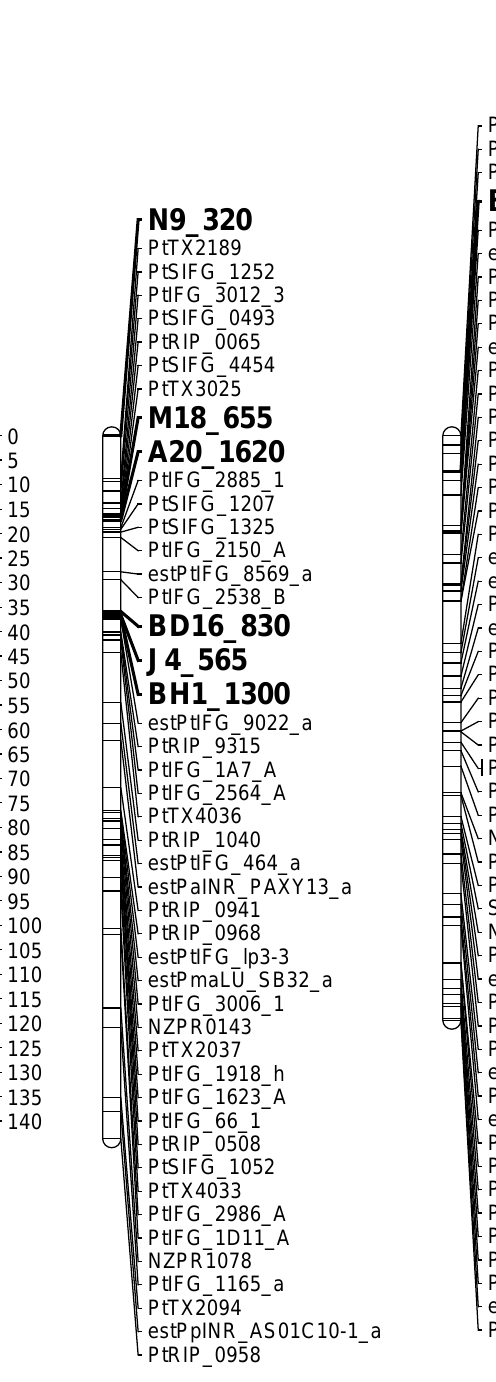
Figure 1. Loblolly pine reference genetic map linkage groups 2, 3, and 10 [37], showing the positions of the Fr gene-linked RAPD markers noted in Table 3. RAPD markers are in larger font and bold